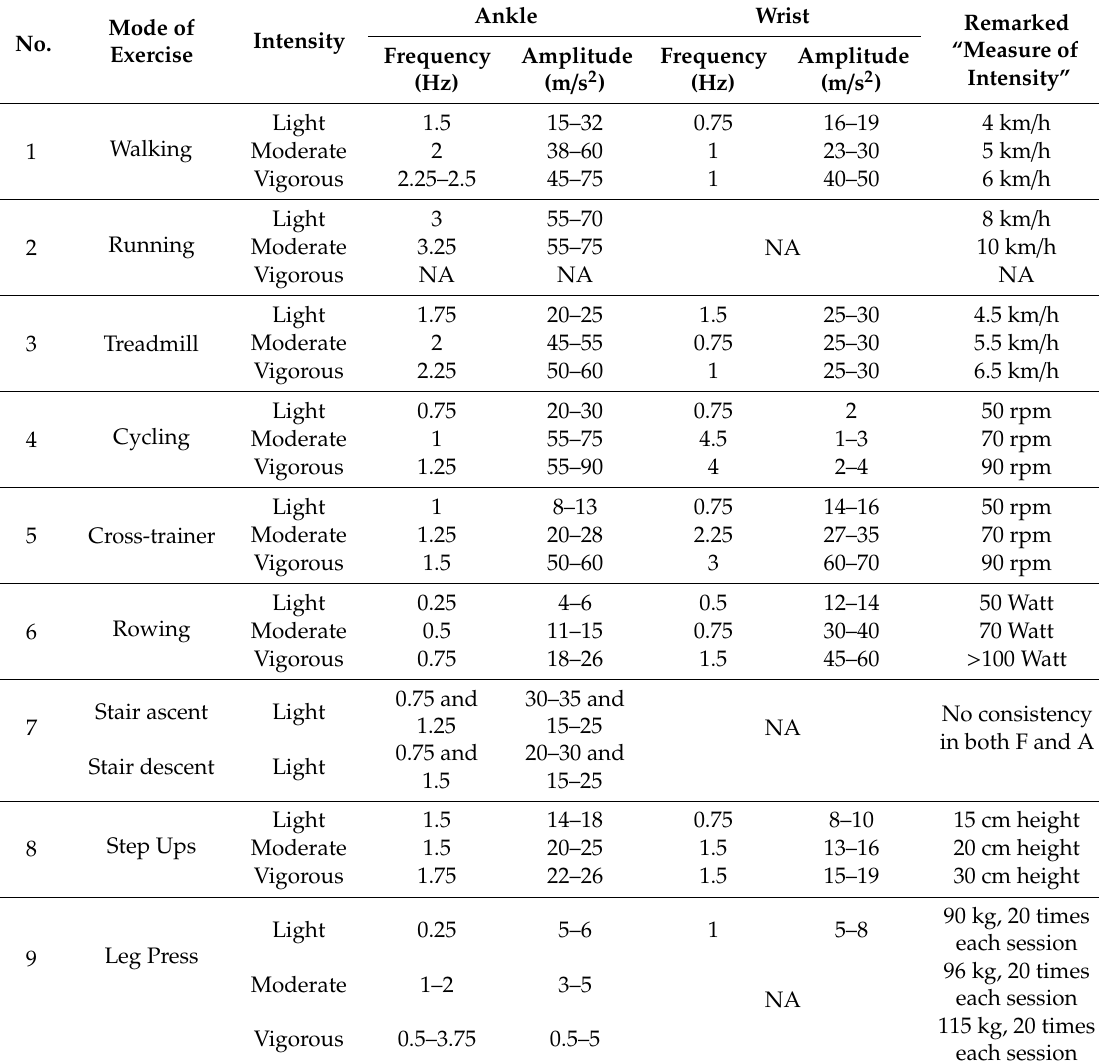
Table 2. Results of analysing 3D accelerometer data for nine di ff erent movements and at three di ff erent intensities collected from a sensor placed on the participant’s ankle and